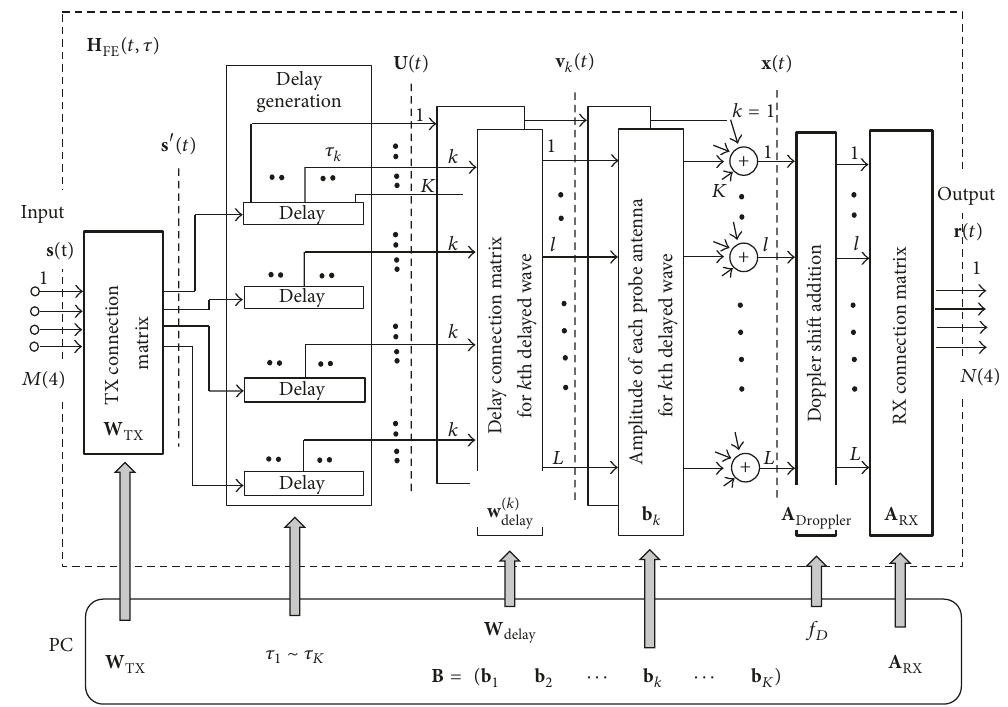
Figure 6: Overall configuration of the MIMO-FE proposed in this